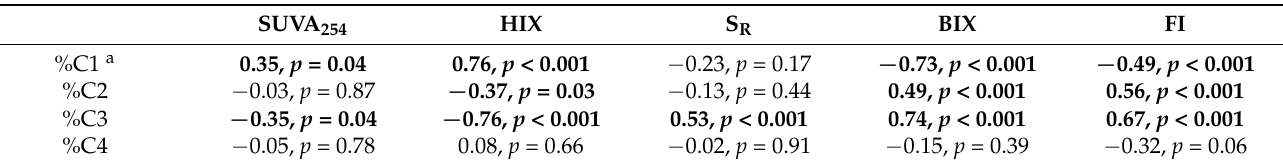
Table 1. Pearson correlation of DOM fluorescence components and optical indices in Mayfield Creek in the southeastern United States.